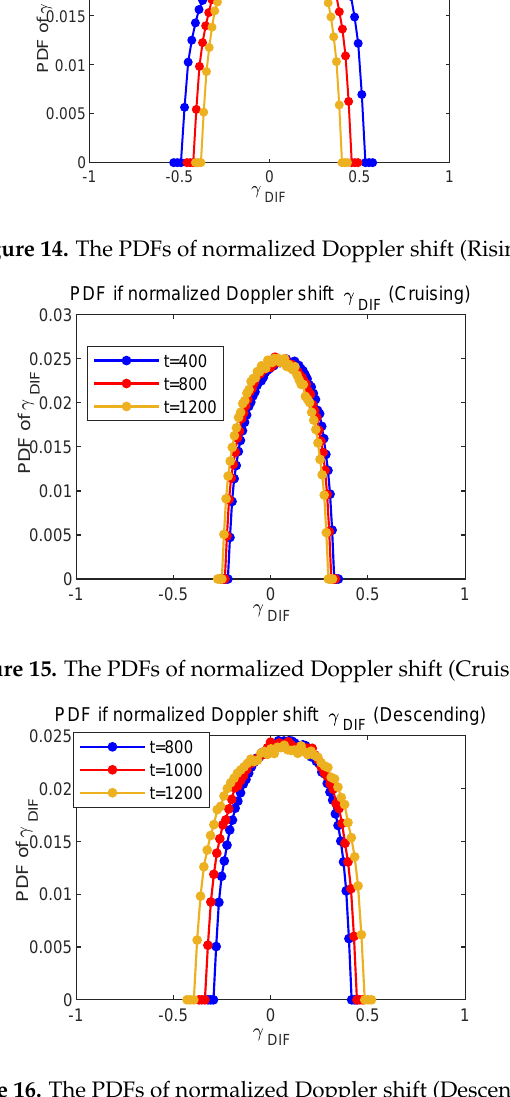
Figure 16. The PDFs of normalized Doppler shift